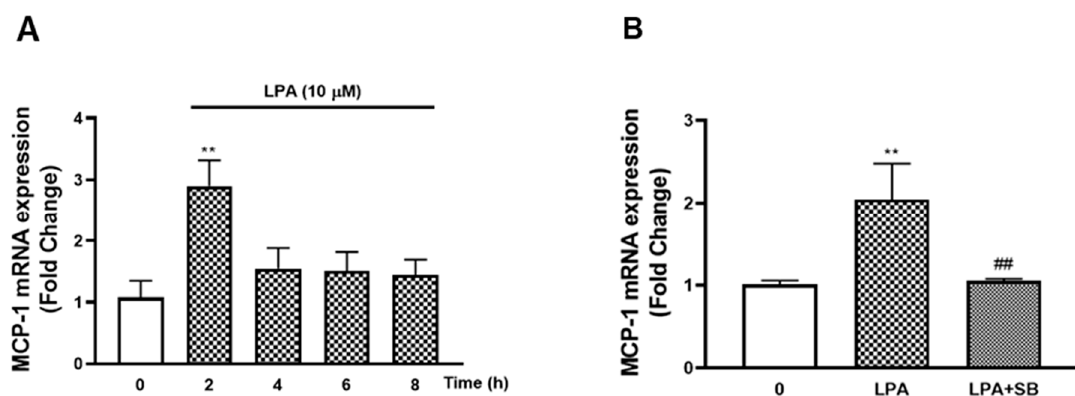
Figure 1. LPA stimulation of MCP-1 and the role of the TGFBR1 transactivation pathway. ( A ) VSMCs were treated with LPA (10 µ M) over an 8 h time course. ( B ) VSMCs were pre-incubated with 3 µ M SB 431,542 for 30 min before treatment with LPA (10 µ M) for 2 h. Total RNA was harvested and assessed by qRT-PCR analysis. 18S was used as a house keeping gene. Results are expressed as mean ± SEM from three independent experiments. Statistical significance was determined by one-way ANOVA, followed by least significant difference post-hoc analysis. ** p < 0.01 versus basal; ## p < 0.01 versus LPA only treated